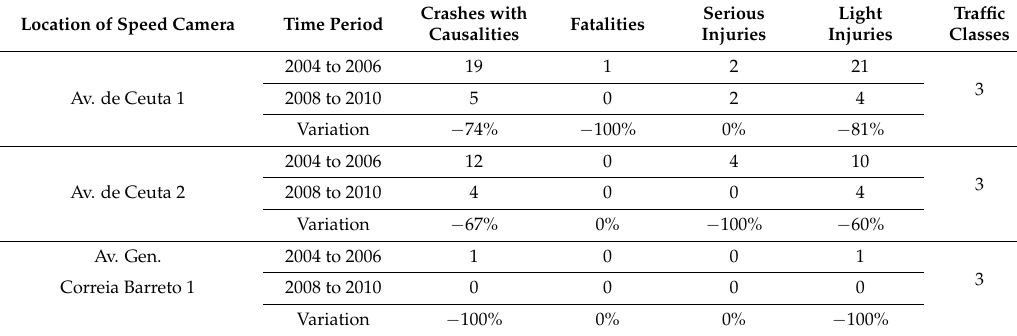
Table 1. Variation of crash indicators in the periods before and after the installation of the speed control cameras.